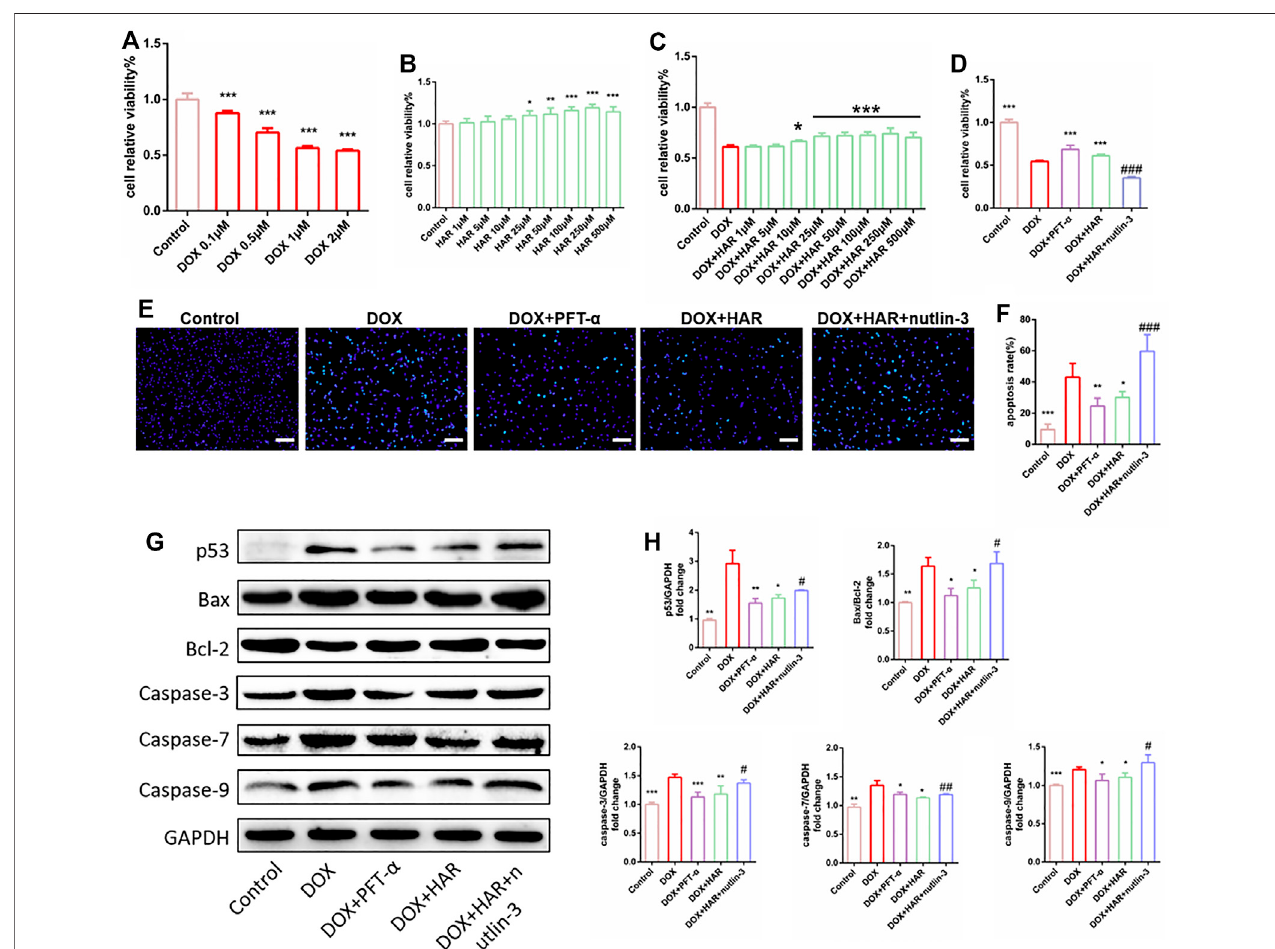
FIGURE 4 | HAR enhanced cell proliferation and inhibited apoptosis by suppressing p53 in vitro . (A) DOX decreased cell viability in dose-dependent manner, as shown by CCK-8 assay ( n = 6). (B,C) Effect of HAR alone and HAR combined with DOX on cell proliferation ( n = 6). (D) Effects of HAR (pretreatment for 24 h), the p53 inhibitor PFT- α (20 μ M) and the p53 activator nutlin-3 (20 μ M) on viability of H9C2 cells in the presence of DOX ( n = 6). (E,F) Representative images and quantitative analysis of apoptosis measured by Hoechst staining. Scale bar: 100 μ m. Hoechst-positive cells were quanti fi ed blindly using 5 images from various fi elds of view ( n = 5). (G,H) Representative immunoblots and quantitative analysis of the expression of p53-dependent mitochondria-derived apoptosis-related proteins. The expression levels were normalized toGAPDH ( n =3 – 6). * p < 0.05, ** p < 0.01, *** p < 0.001 vs. DOX group ( n = 3 – 6). # p < 0.05, ### p < 0.001 vs. (DOX + HAR) group. The data are shown as the mean ±